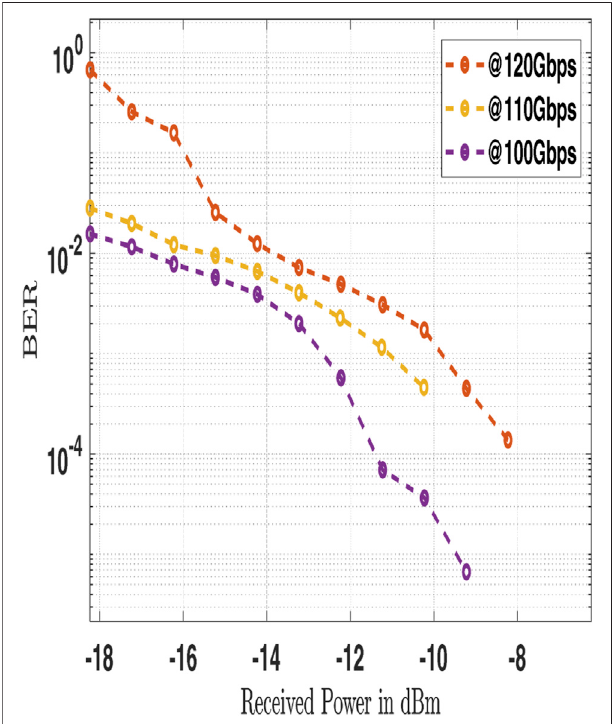
FIGURE 11 | Received power vs